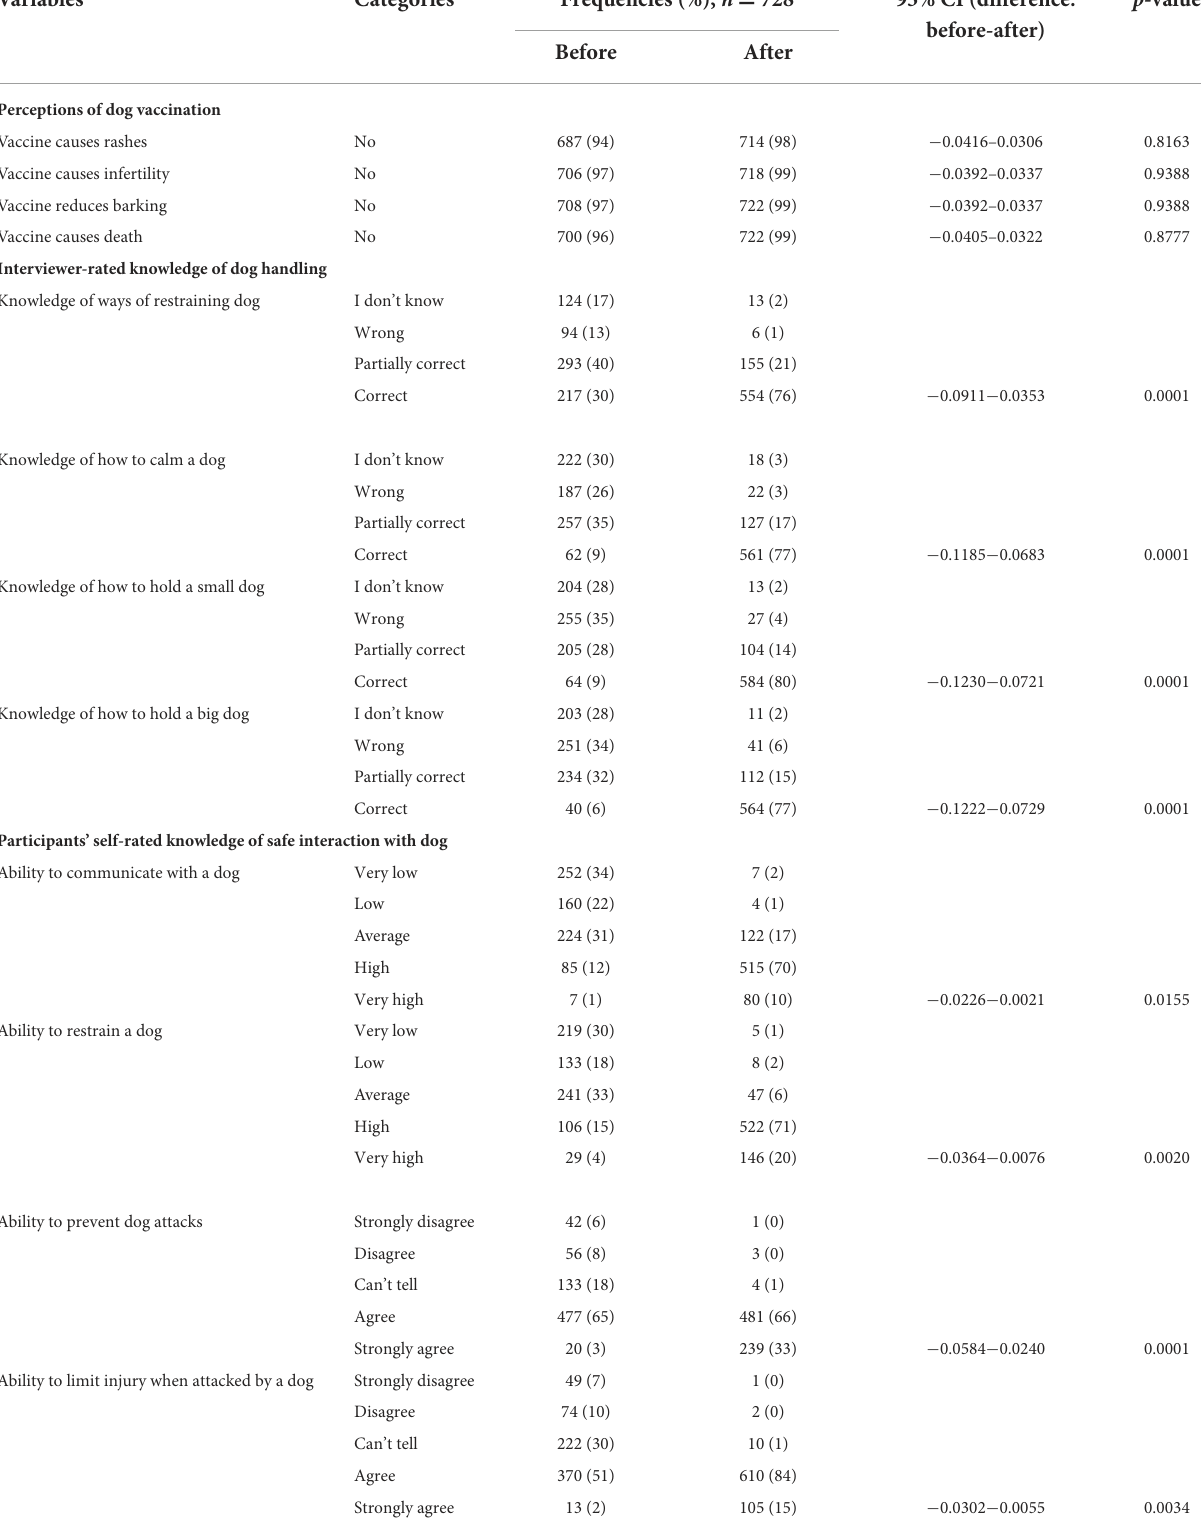
TABLE 3 Change in perceptions of dog vaccination, interviewer and participant-rated knowledge of dog handling and safe interaction with dogs: before and after the engagement activity. Variables Categories Frequencies (%), n = 728 95% CI (difference: